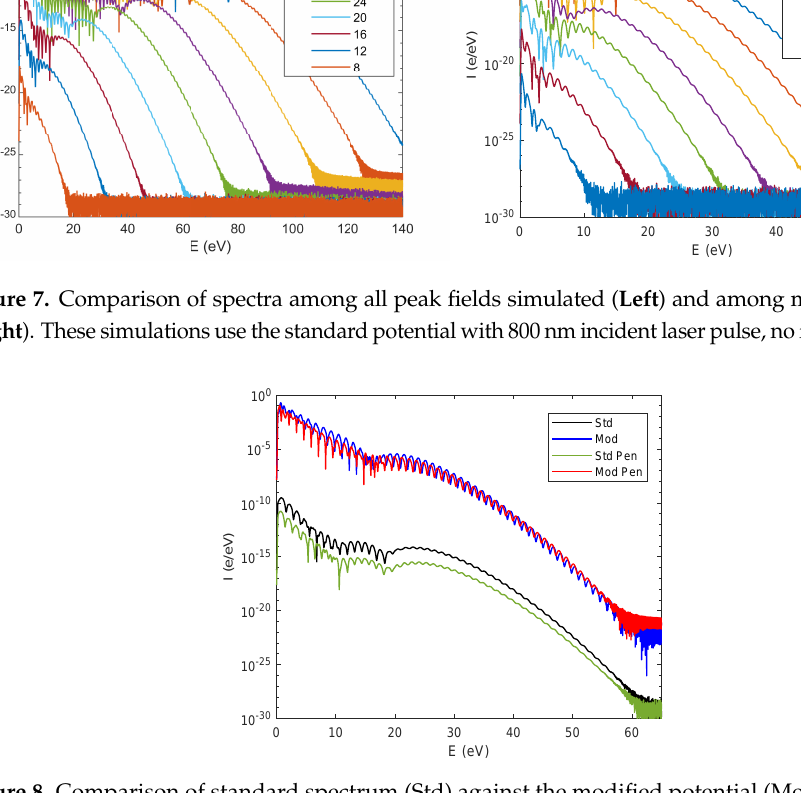
Figure 8. Comparison of standard spectrum (Std) against the modified potential (Mod) (scaled to set ground state to 4.7 eV), penetrating field (Std Pen), and the penetrating field with modified potential (Mod